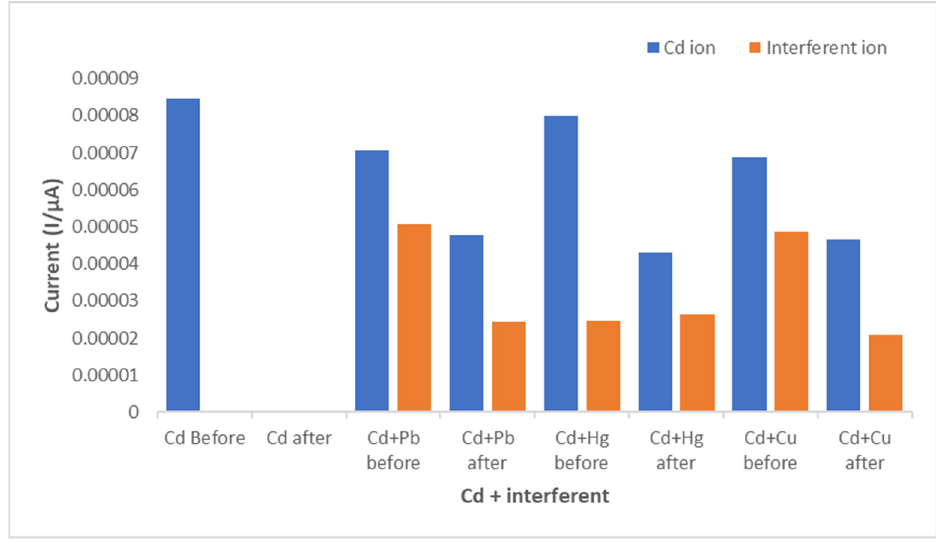
Figure 13. Interference studies during Cd 2+ detection under optimized conditions .